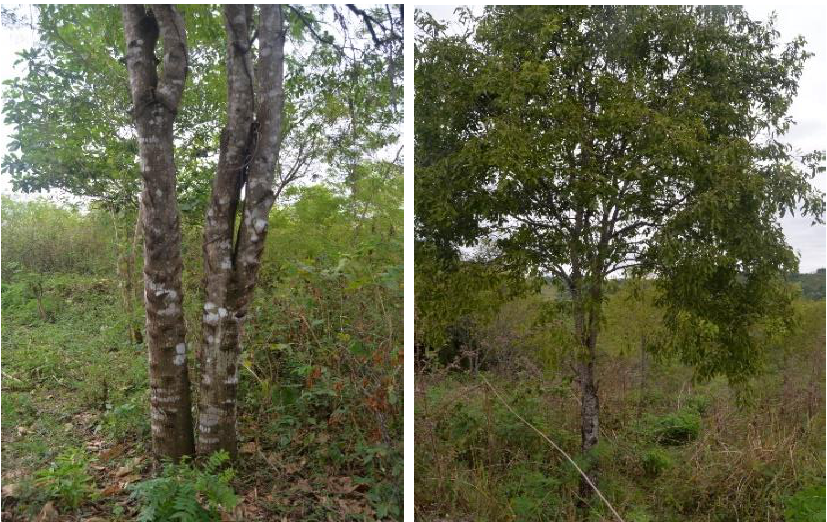
Figure 4. Natural regeneration of sandalwood on private land around the settlement of local com- munities in Sumba.